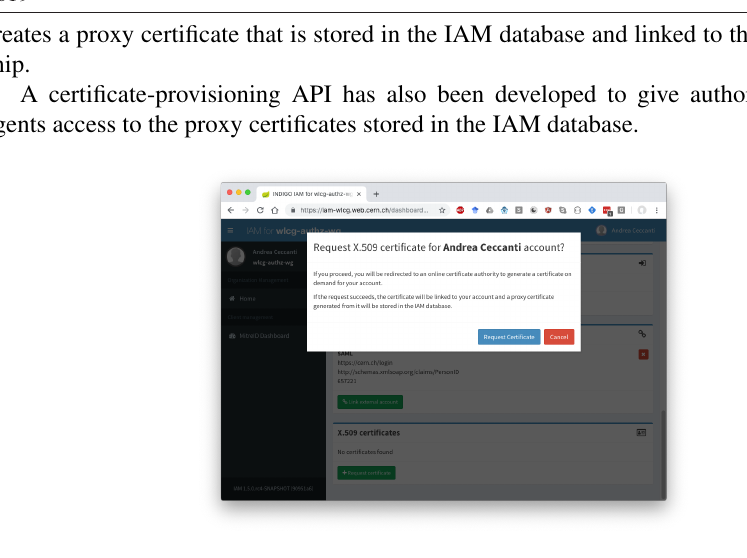
Figure 2. The generation of an X.509 certificate can be requested directly from the IAM